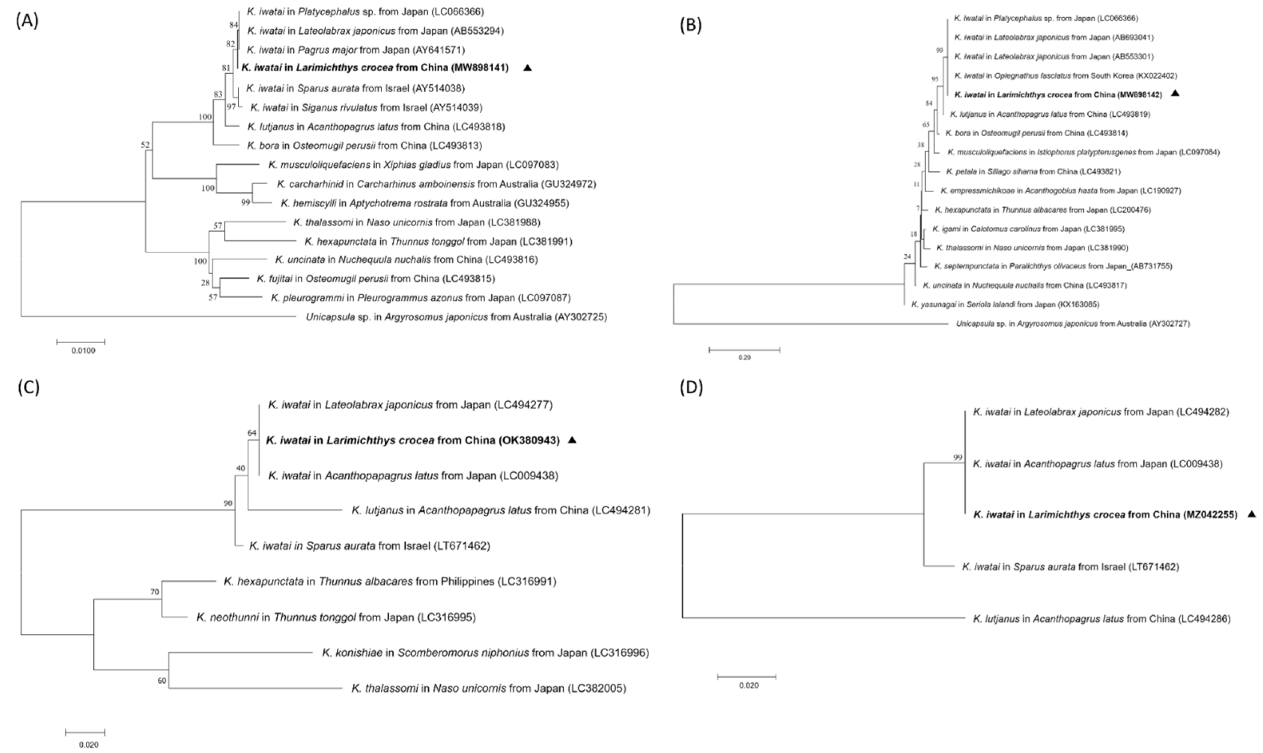
Figure 6. Phylogenetic trees of Kudoa . ( A ) Neighbor-joining (NJ) phylogenetic trees based on the SSU sequence dataset. ( B ) Neighbor-joining phylogenetic trees based on the LSU sequence dataset.